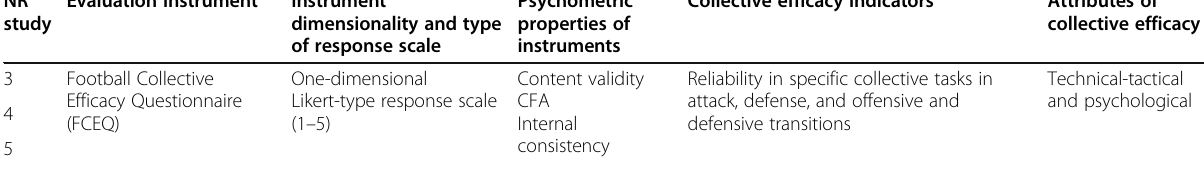
Table 2 Characterization of the instruments used in the studies included in this systematic